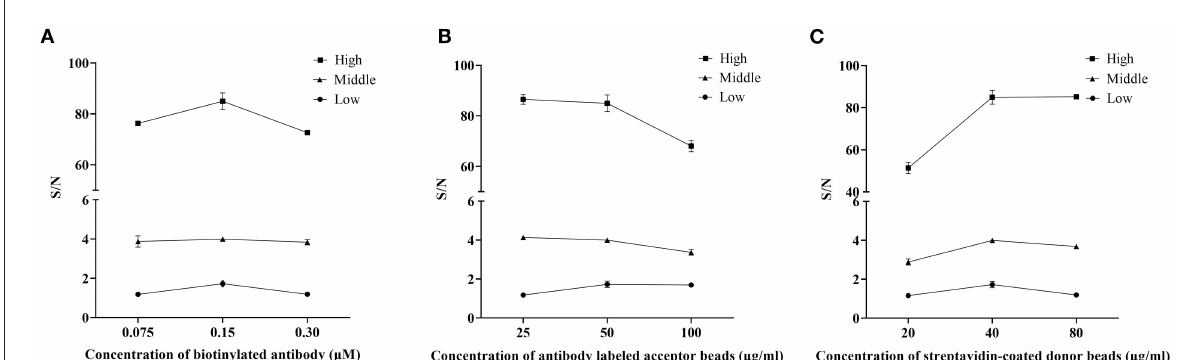
FIGURE1 Optimization of the AlphaLISA experiment. The effect of a single variable on AlphaLISA S/N was examined by making the other factors constant. (A) Effect of the concentration of biotinylated antibodies ( µ M); (B) Effect of the concentration of antibody labeled acceptor beads ( µ g/ml); (C) Effect of the concentration of streptavidin-coated donor beads ( µ g/ml). Low: the low concentration of rotavirus antigen (dilution ratio: 5 − 7 ); Middle: the middle concentration of rotavirus antigen (dilution ratio: 5 − 5 ); High: the high concentration of rotavirus antigen (dilution ratio: 5 − 3 ). Mean values from 3 trials are plotted, with error bars denoting the standard deviation.